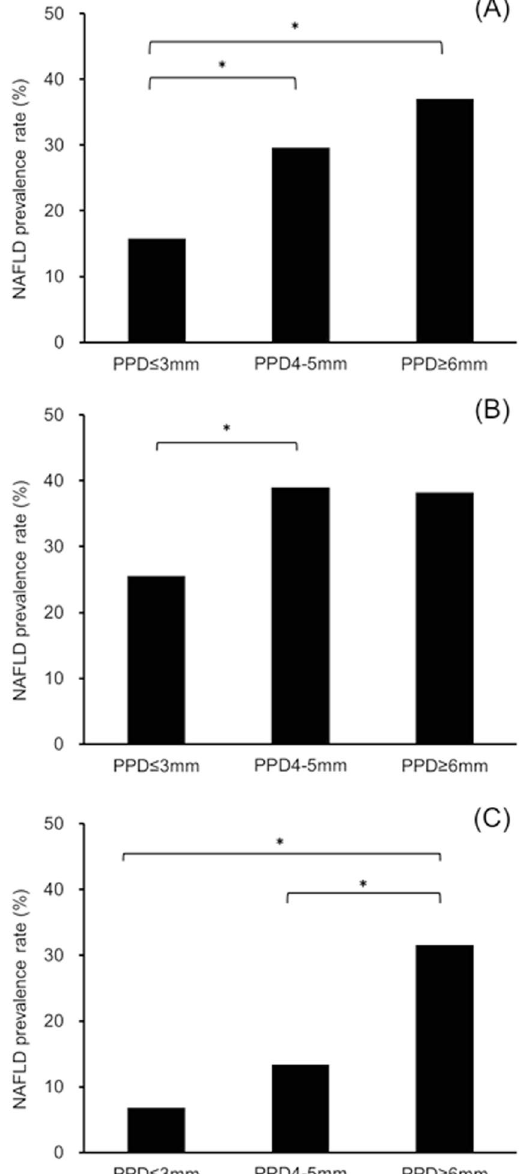
pocket depth. * p < 0.05, compared with the participants with PPD ≤ 3 mm, using the Kruskal Wallis test with post hoc Mann Whitney U test (corrected Bonferroni’s